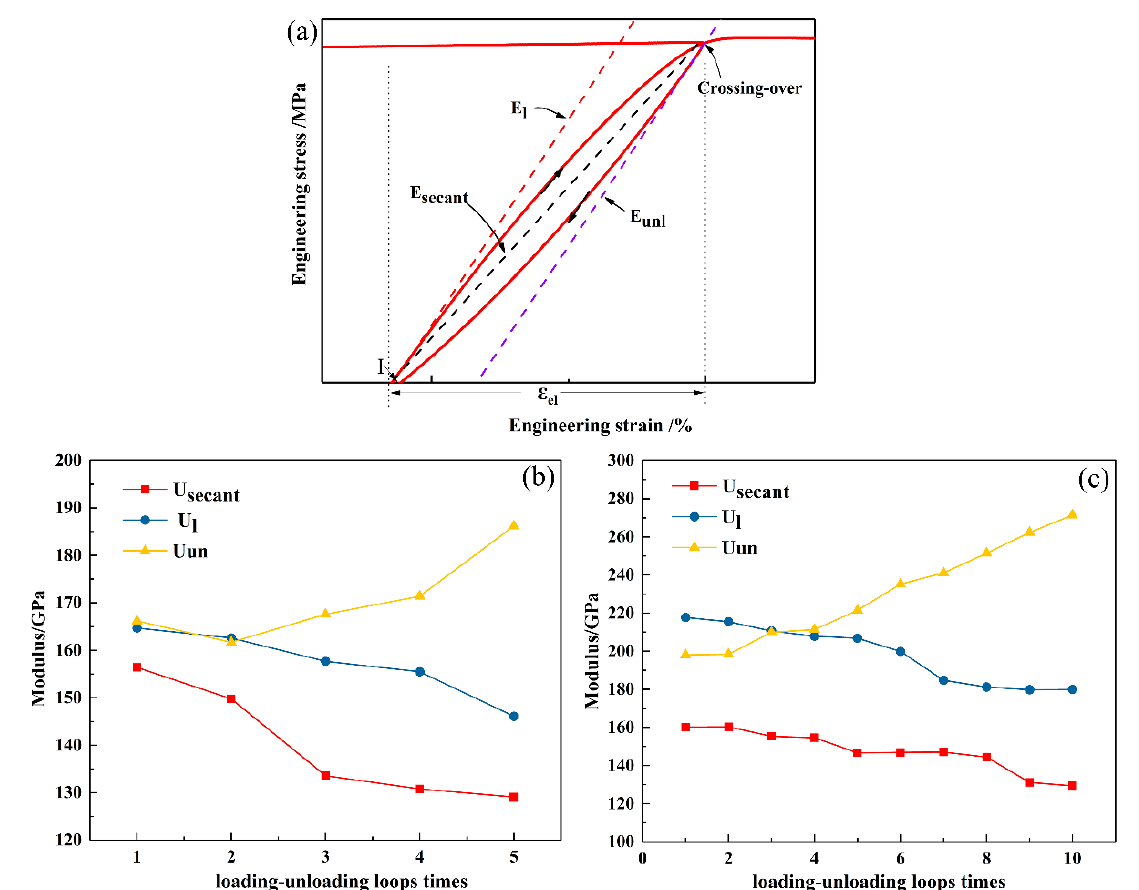
Figure 5. ( a ) Schematic engineering stress–strain curve from the cyclic loading–unloading tensile tests; ( b ) secant modulus E secant , loading modulus E l , and unloading modulus E un of 5-TC-UT; ( c